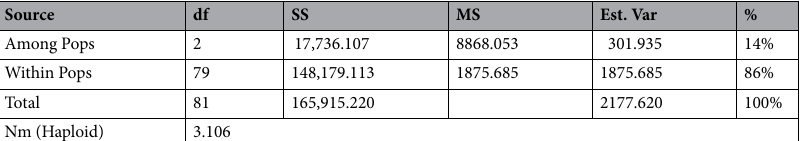
Source df SS MS Est. Var % Among Pops 2 17,736.107 8868.053 Within Pops